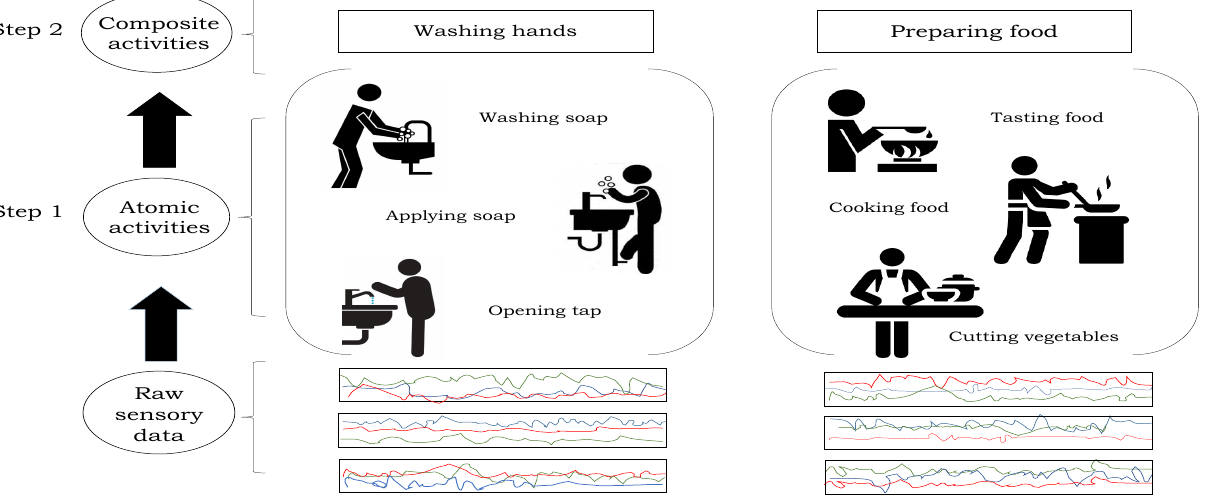
Figure 1. Hierarchical model to recognize human activities. In the first step, the atomic activities are detected from the original sensory data, and their recognition scores are obtained, which are used to recognize the composite activities in the second